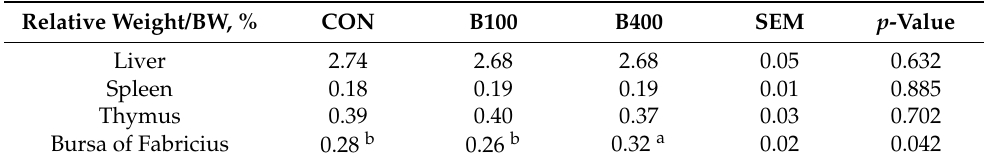
Table 3. Effects of dietary supplementation with bilberry extract on the relative weight of immune organs of yellow-feathered chickens 1